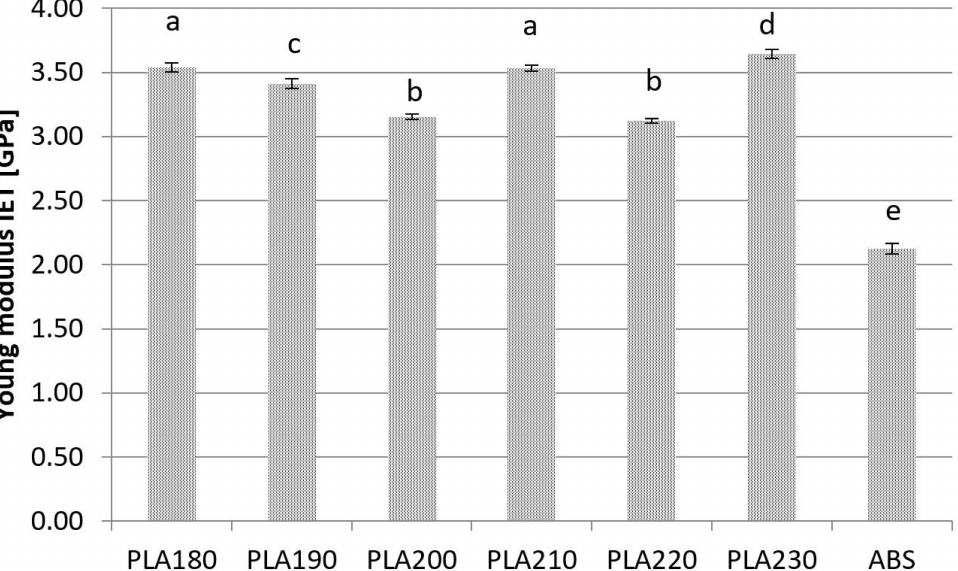
Figure 5. Young’s modulus values measured by IET. Bars with the different letters (a, b, c, d, e) are significantly